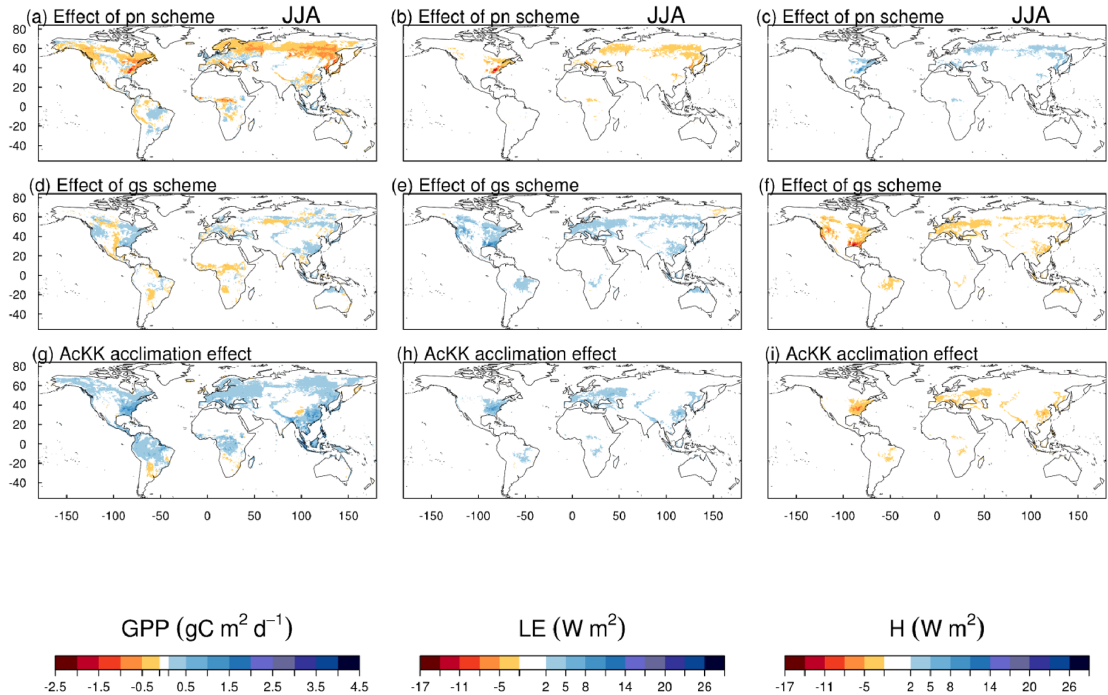
Figure 7. The difference of difference approach (Eq. 12) to determine the impact on GPP (gCm 2 d − 1 ), LE and H (both Wm 2 ) of the individual changes to each JULES model configuration over the course of the future (HadGEMGC3.1) simulation (1980 to 2050) in June– July–August (JJA). The AcKK.Med acclimation effect is calculated from Fig. S16 AcKK.Med–Fq.Med, the effect of the Medlyn g s scheme is calculated from Fig. S16 Fq.Med–Fq.Jac and the effect of the photosynthesis scheme is calculated from Fig. S16 Fq.Jac–Clz.Jac.